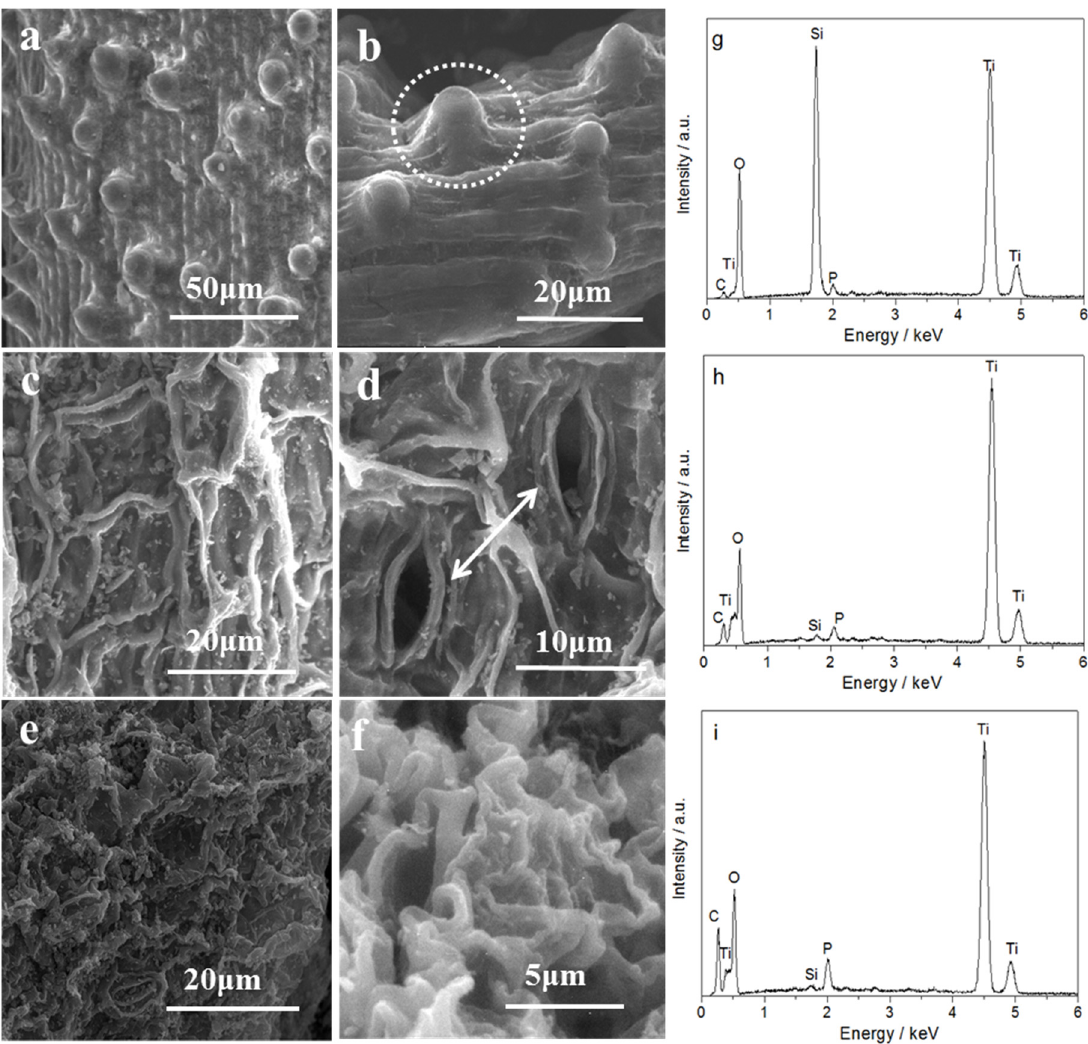
Figure 4. Scanning electron microscopy (SEM) images and energy dispersive X-ray spectroscopy (EDS) spectra: ( a ) original reeds; ( b ) and ( g ) R-TiO 2 /SiO 2 ; ( c ) original water hyacinth; ( d ) and ( h ) WH-TiO 2 /SiO 2 ; ( e ) original duckweed; ( f ) and ( i ) D-TiO 2 /SiO 2 .